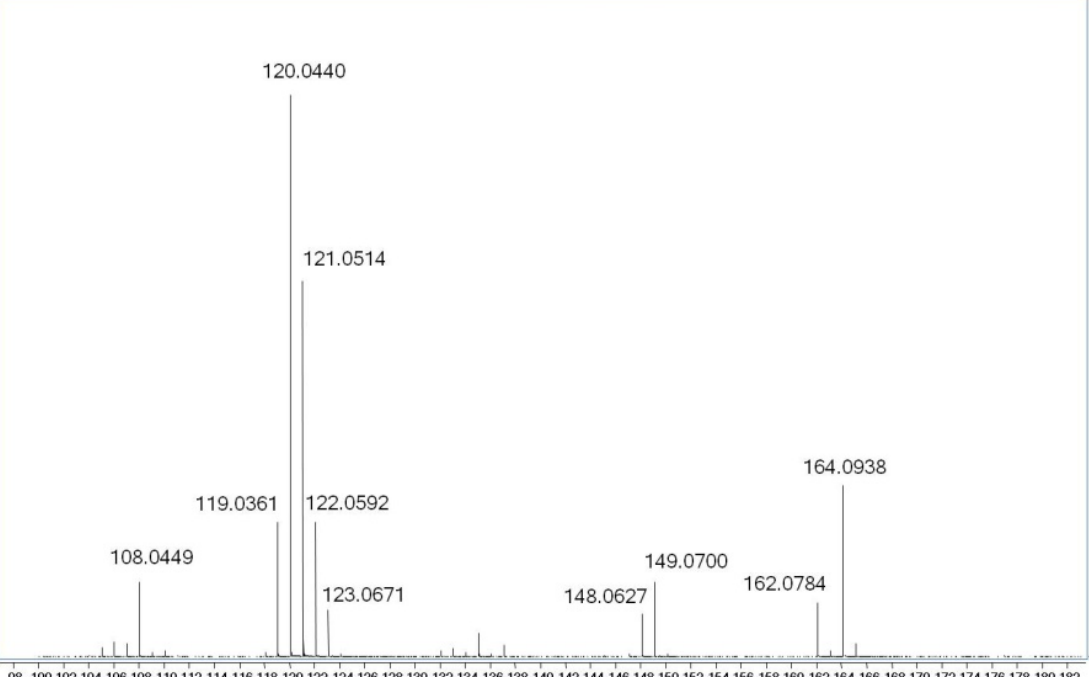
Figure 5. Pseudo-MS 3 fragmentation of m/z 164.0924 derived from the m/z 296.1350 ion of synthetic m 6 2